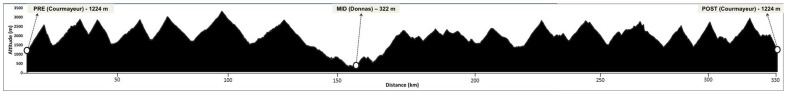
GPS track of the entire run with the three test session locations and the distance scale in km.